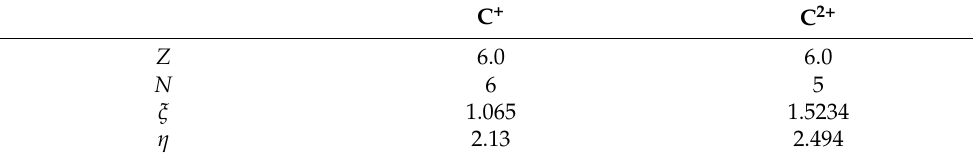
Table 1. Garvey model potential parameters for the C + and C 2+ ions as provided in Ref. [13]. C + C 2+